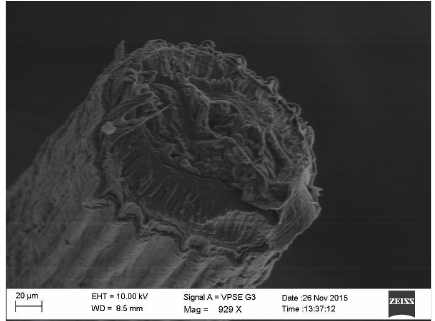
Figure 8: A cross section of the worm showing cuticular ridges and thick